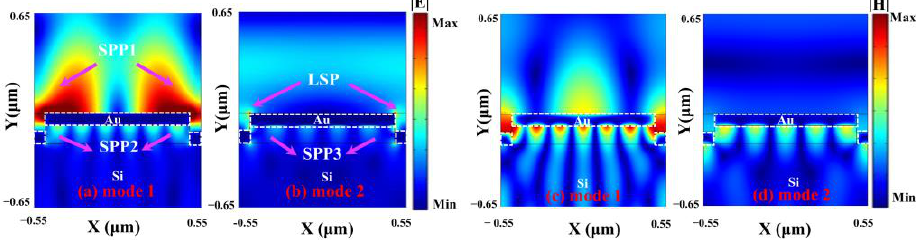
Figure 4. ( a , b ) Electric field distribution of Mode 1 and Mode 2, respectively. ( c , d ) Magnetic field distribution of Mode 1 and Mode 2, respectively.